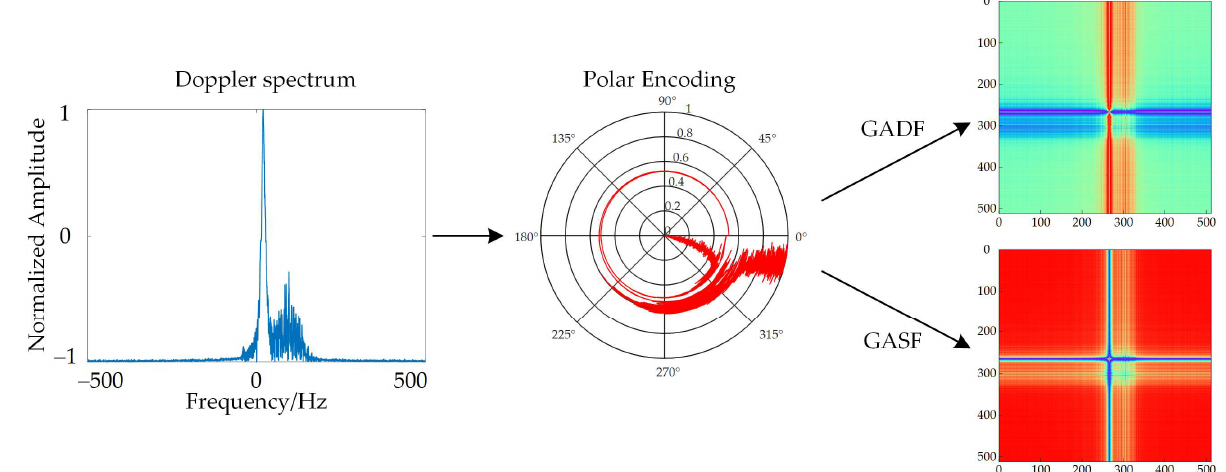
Figure 4. Schematic diagram of the conversion of Doppler spectral sequences into GAF maps.